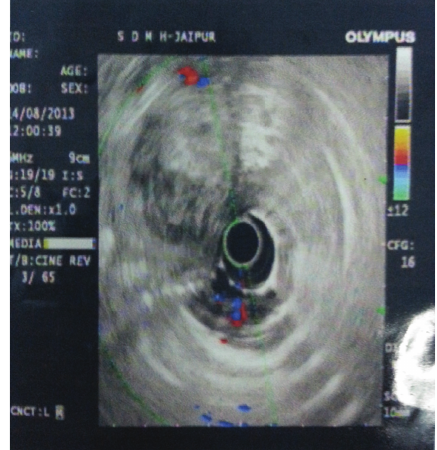
Figure 2: EUS Doppler depicting a mass in wall of stomach.